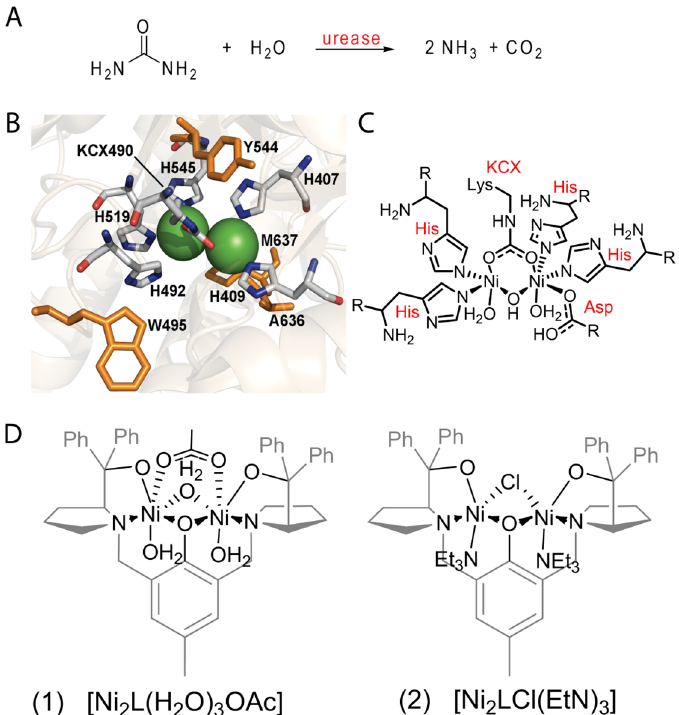
Figure 1. Scheme of the reaction performed by urease enzyme ( A ), generic active site of a urease enzyme. In orange are the hydrophobic amino acids which surround the active site ( B , C ) and bis -nickel complexes, [Ni 2 L(H 2 O) 3 (OAc)] (1) and [Ni 2 L(Cl)(Et 3 N) 2 ](2) (2), based on ( RS , RS )-Trost-bis- ProPhenol (L) ligand ( D ).